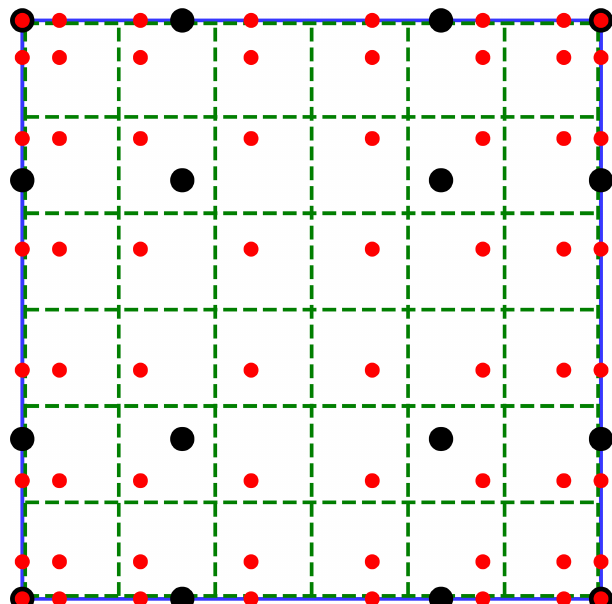
Figure 1. Diagram of subelement grids. One spectral element (blue solid line outlining the full square) with dynamics ( n v p = 4, black large circles), tracer ( n t p = 8, small red circles), and physics ( n f = 6, green dashed lines) subelement